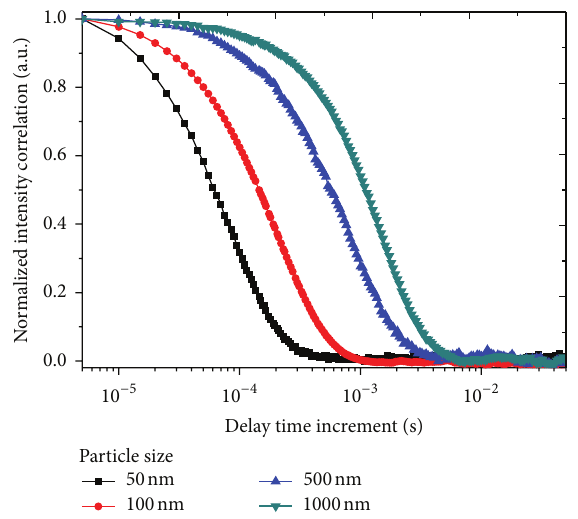
Figure 3: Normalized correlation curves of the intensity of scatter- ing light for nanoparticles of different sizes.